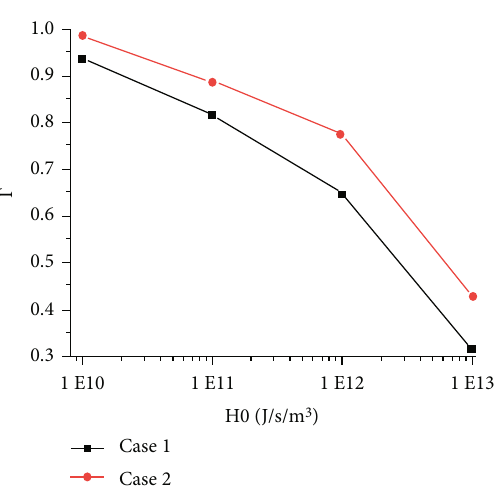
Figure 13: Variation trend of the local heat release ratio with enthalpy changes.